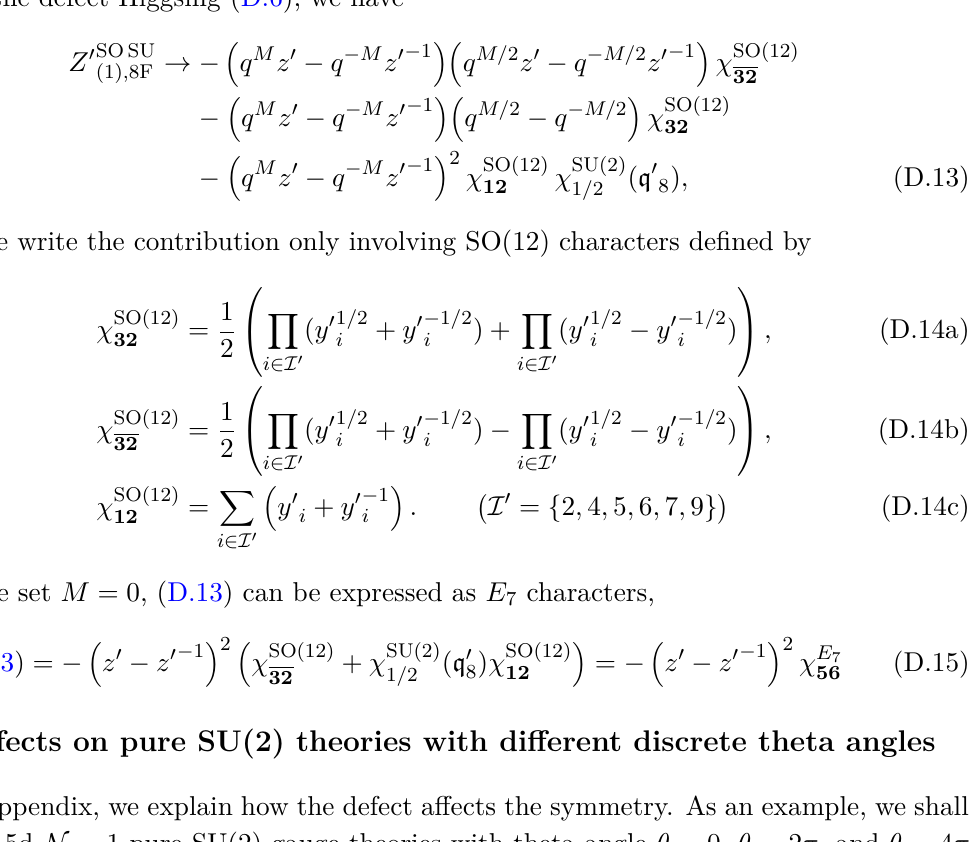
Figure 16 . The web diagram descriptions of pure SU(2) gauge theories with θ = 0 , 2 π, and 4 π . By the defect Higgsing (D.6), we